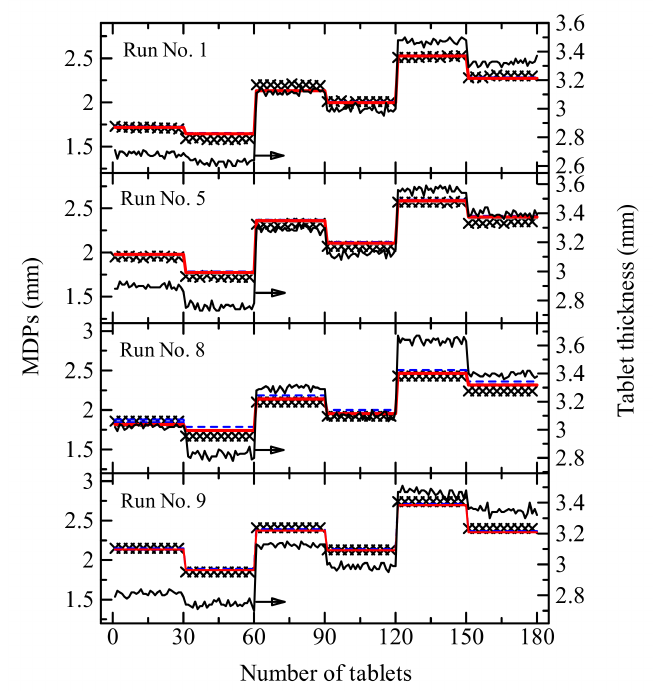
Figure 4. Actual setting ( × ) and predictive control of MDPs for the desired tablet weight and thickness by the NIR model (gray dashed line), physical attribute model (blue dashed line), and combination model (red solid line). The black solid line indicates actual thickness of tablets. The prediction was performed for batches of the four runs (No. 1, 5, 8, and 9) shown in Table 2. The prediction of No.9 data was performed as an external validation using the calibration model prepared excluding run No. 7 data. The desired values of tablet weight and thickness are shown in the